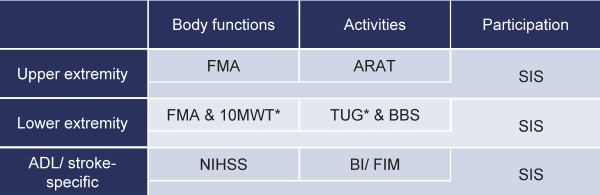
TABLE 2 | Core set of outcome measures for clinical motor rehabilitation after stroke.